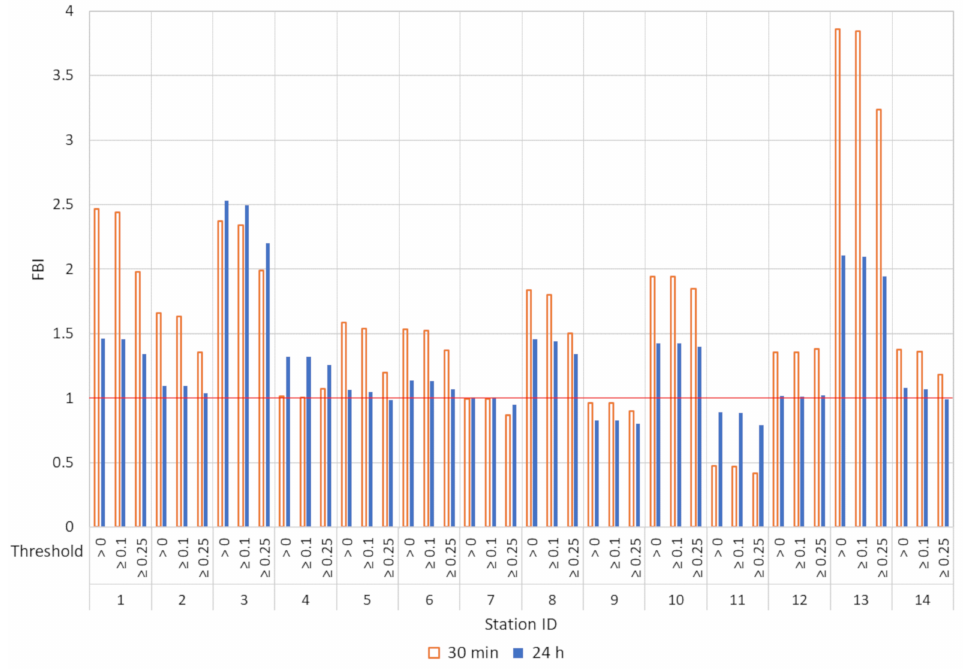
Figure 5. Frequency bias index (FBI) results by station for di ff erent analyzed